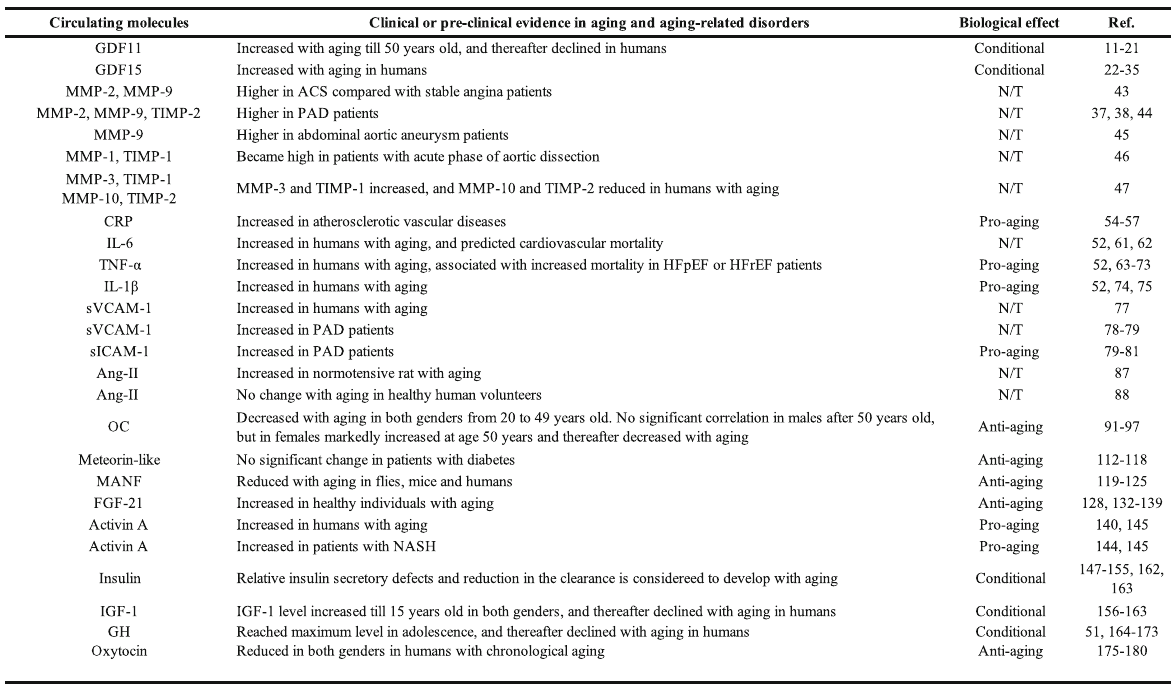
Table 1 The dynamics, clinical or pre-clinical evidence, and biological effect of circulating proteins or peptides in aging and age- related